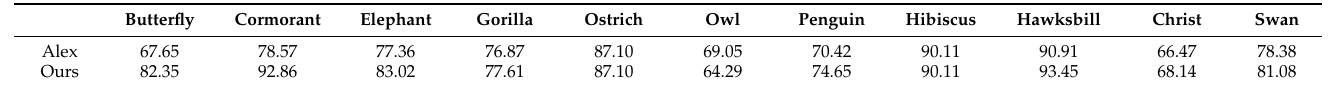
Table 4. Classification accuracy of Caltech-256 (selected classes).